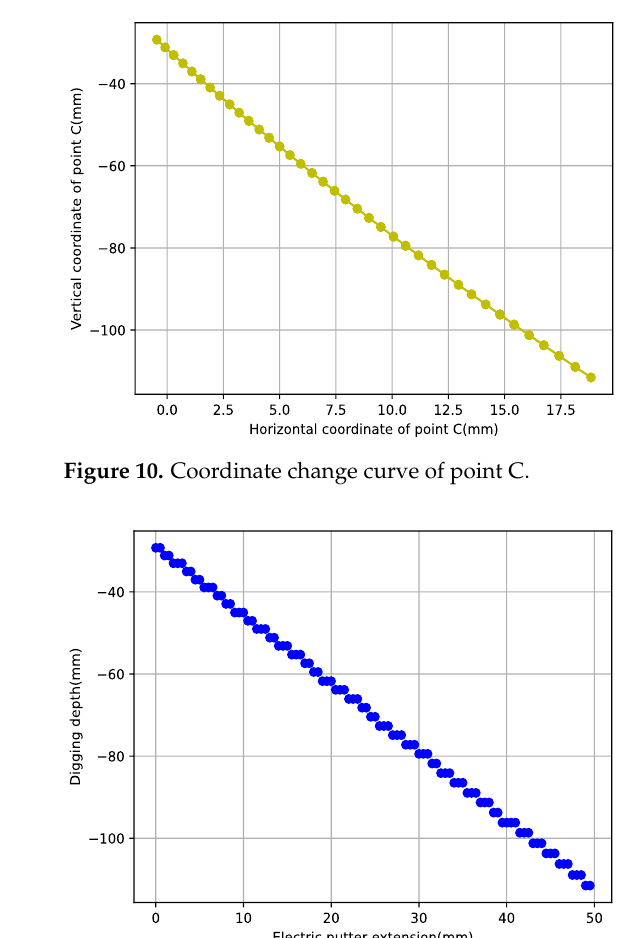
Figure 11. Sampling graph of electric putter extension and digging depth.